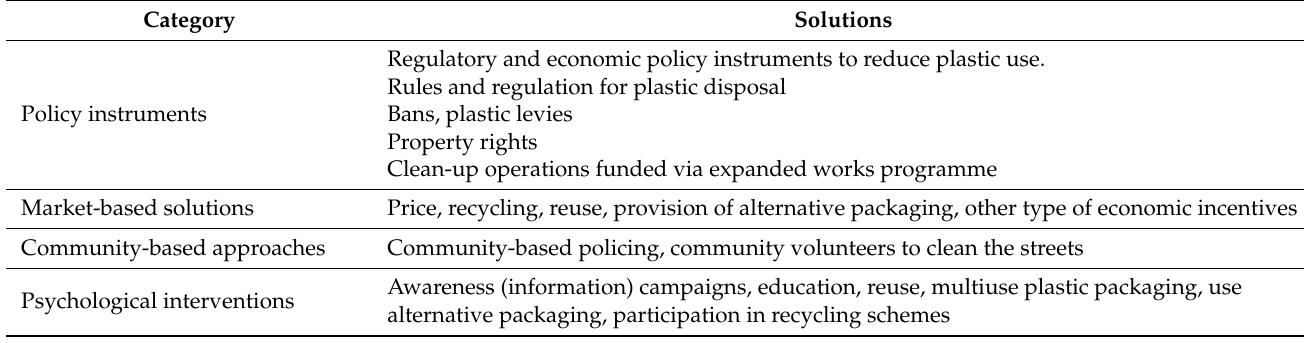
Table 3. Classification of